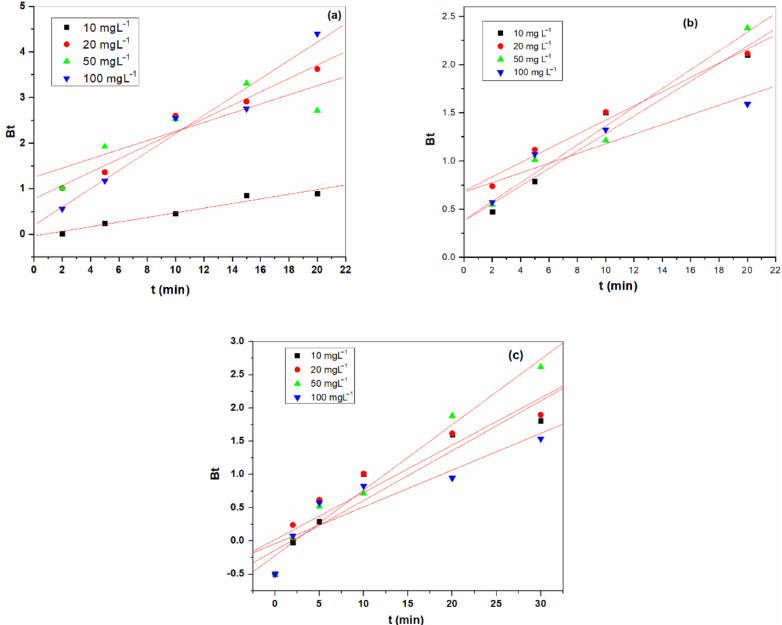
Figure 8. Boyd model applied for the sorption of Congo red on soil ( a ) IS-65, ( b ) IS-T, ( c )